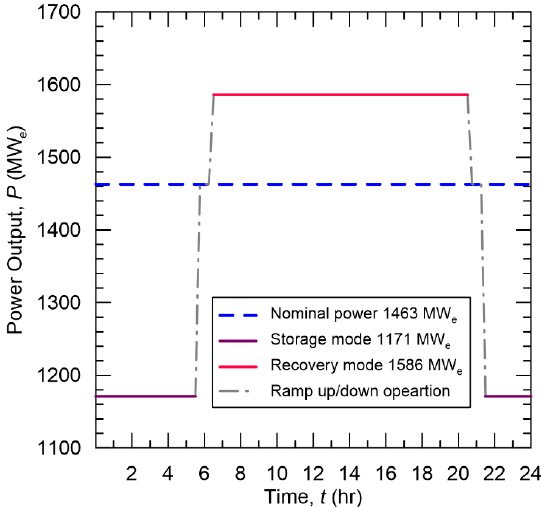
Figure 2. APR1400 NHS&R diurnal operation diagram.